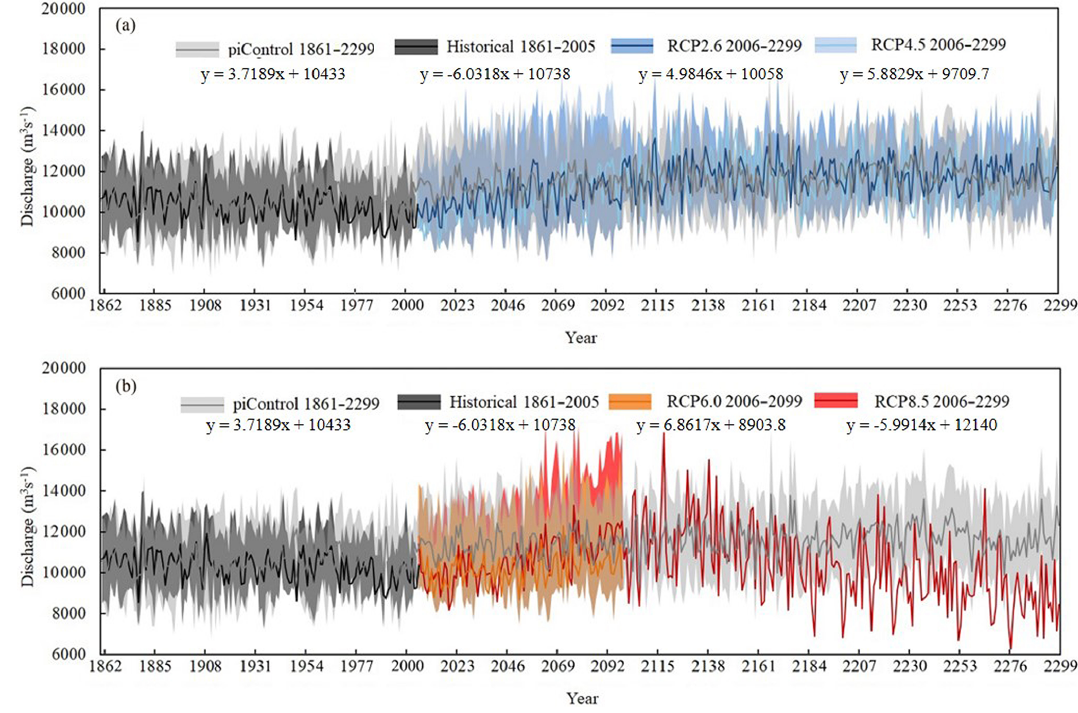
Figure 9. The annual mean discharge at the Cuntan station simulated by four hydrological models (HBV, SWAT, SWIM and VIC) under the piControl scenario and scenarios with anthropogenic climate change effects (a, b) . Table 7. Relative changes in mean annual discharge, Q 10 and Q 90 in the periods 2070–2099 and 2270–2299 under the scenarios of anthro- pogenic climate change relative to the piControl scenario. Relative change of Relative change Relative change Standard Coefficient Period Scenarios mean discharge (%) of Q 10 (%) of Q 90 (%) deviation of